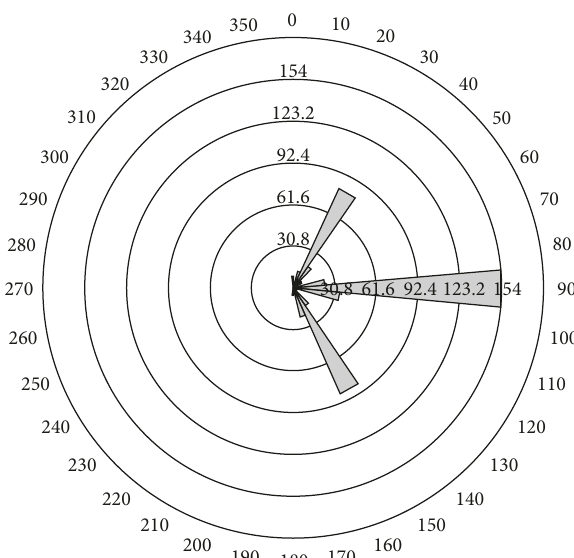
Figure 16: The rose diagram of crack